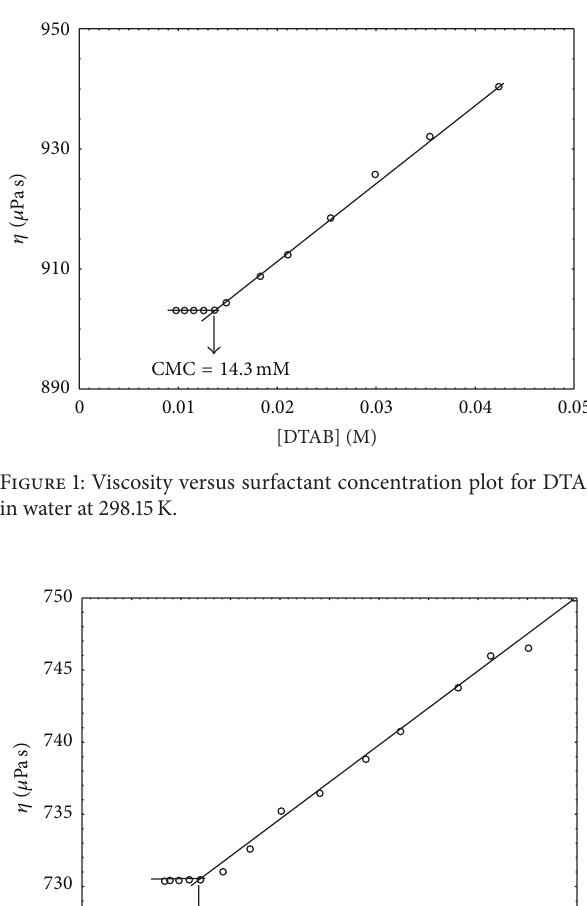
Table 1: Properties of methanol-water mixtures containing (0.10,